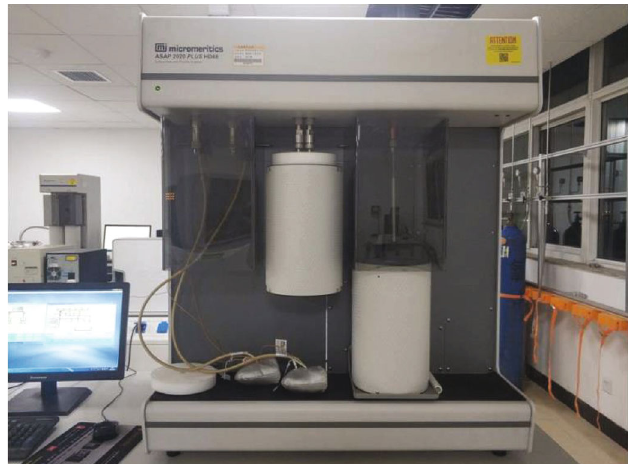
Figure 3: Calculation of the rock sample porosity